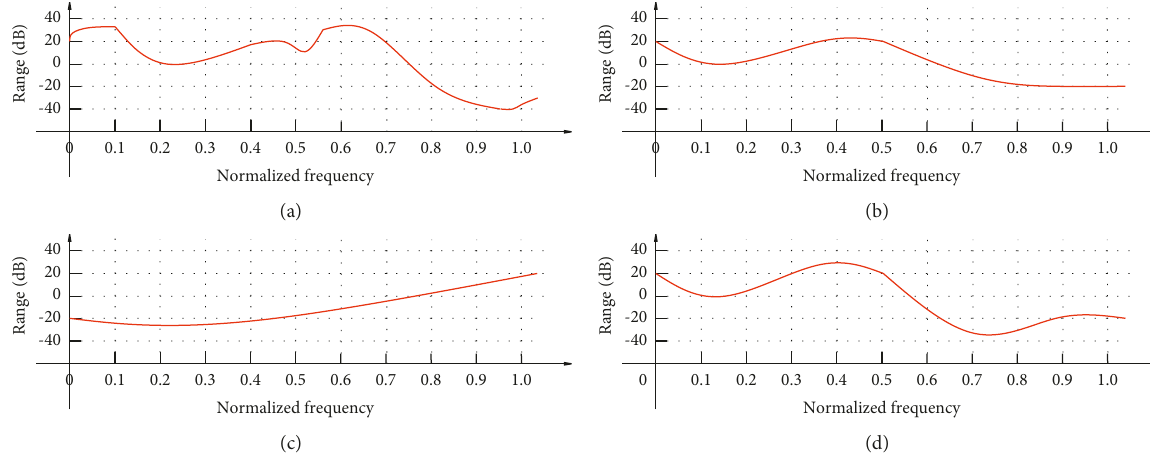
z / r 2 ) frequency response. (